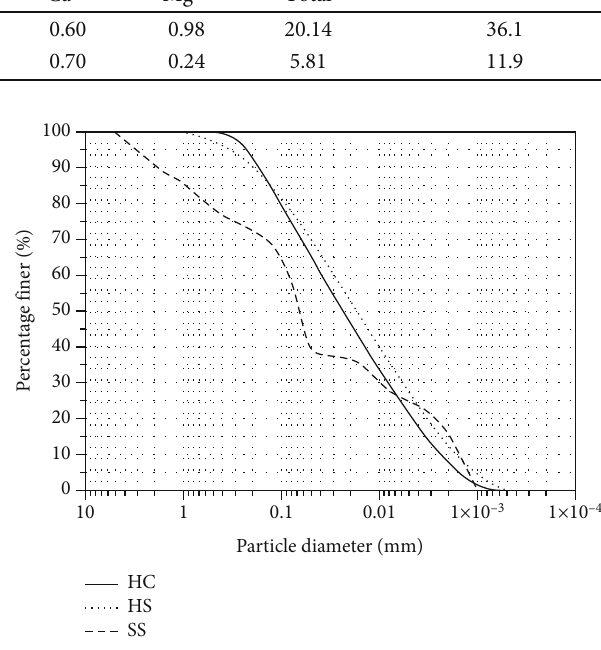
Figure 2: Particle size distribution of three soil